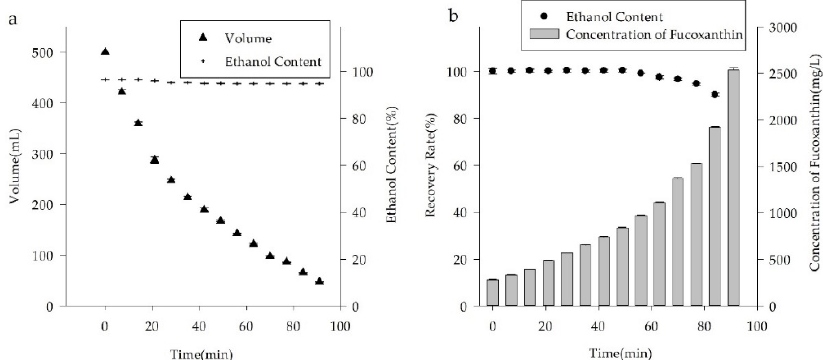
Figure 4. The variations of four key parameters during the vacuum evaporation process. ( a ) The volume and ethanol content of the concentrated solution. ( b ) The concentration and recovery rate of FX in the concentrated solution.